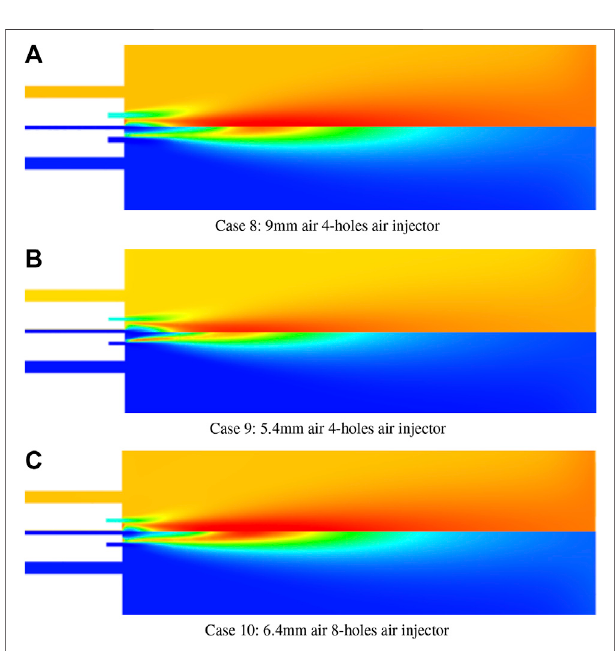
FIGURE 8 | Temperature contours for different inlet geometries with 70% H 2 content (cases 8 – 10).